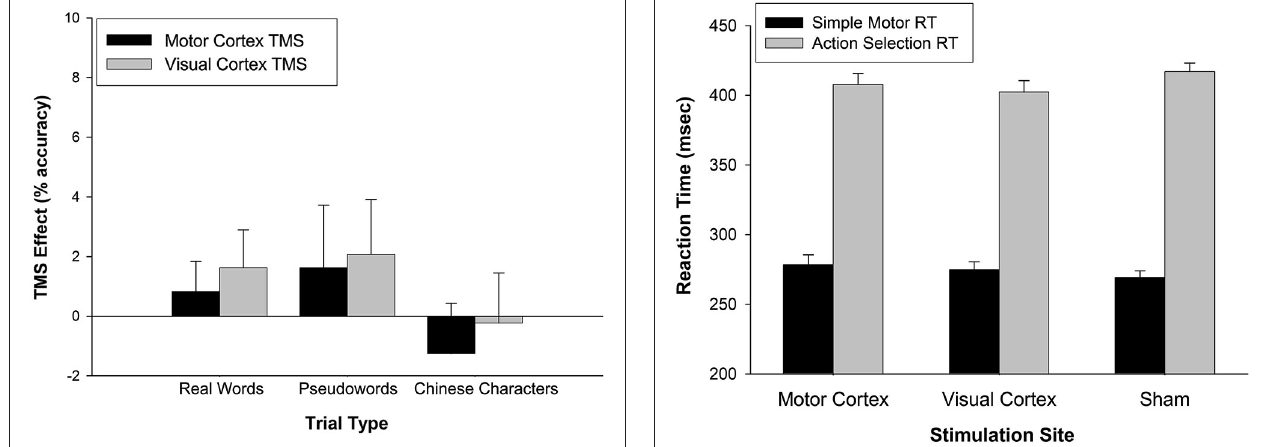
FIGURE 4 | General effect of TMS on reaction time . In a simple motor response task, RTs for motor TMS were comparable to RTs for visual TMS and Sham. When a simple action selection was introduced (choose button 1 or 2), RTs slowed generally ( p < 0.001), but not as a function of stimulation site ( p < 0.14). These findings indicate that motor TMS effects on finger response were not the primary cause of slowed RTs during working memory (in Figure 2 ). Error bars denote standard